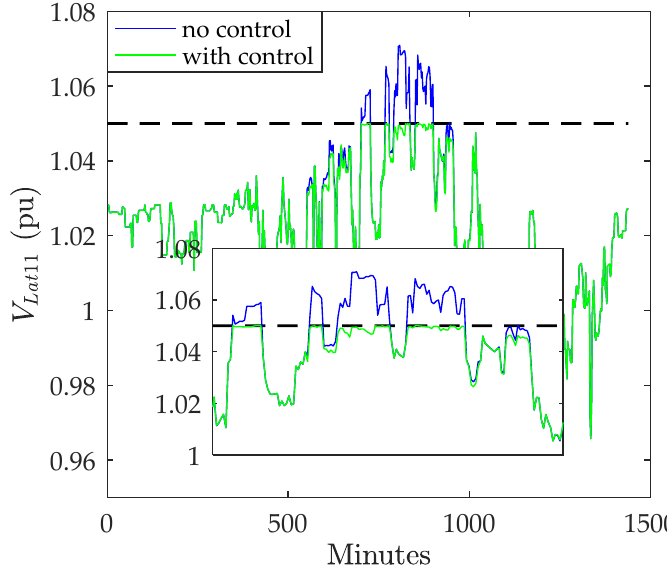
Figure 16. Voltage on lateral 11 without and with control.